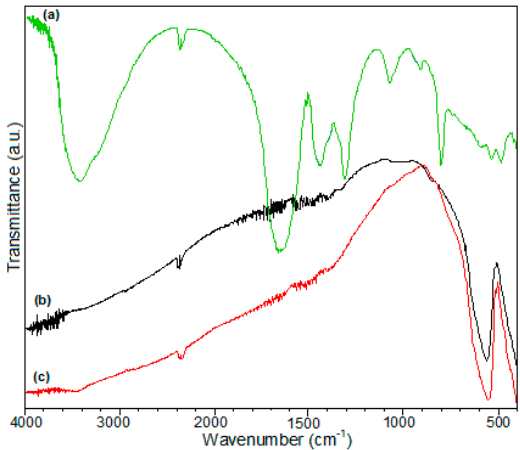
Figure 1. IR vibrational spectra of LaFe(C 2 O 4 ) 3 · 3H 2 O compound ( a ), LaFeO 3 550 ◦ C ( b ) , and LaFeO 3